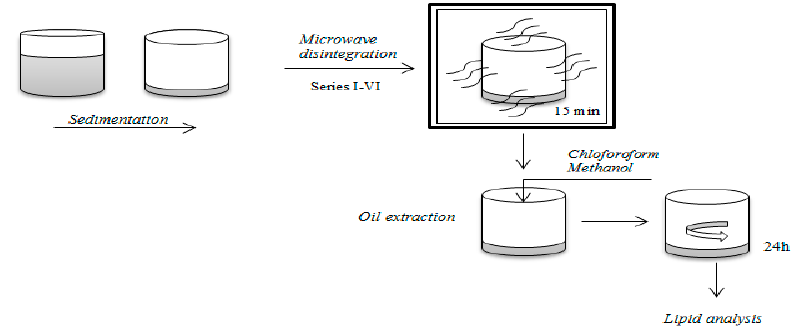
Figure 1. Organization of